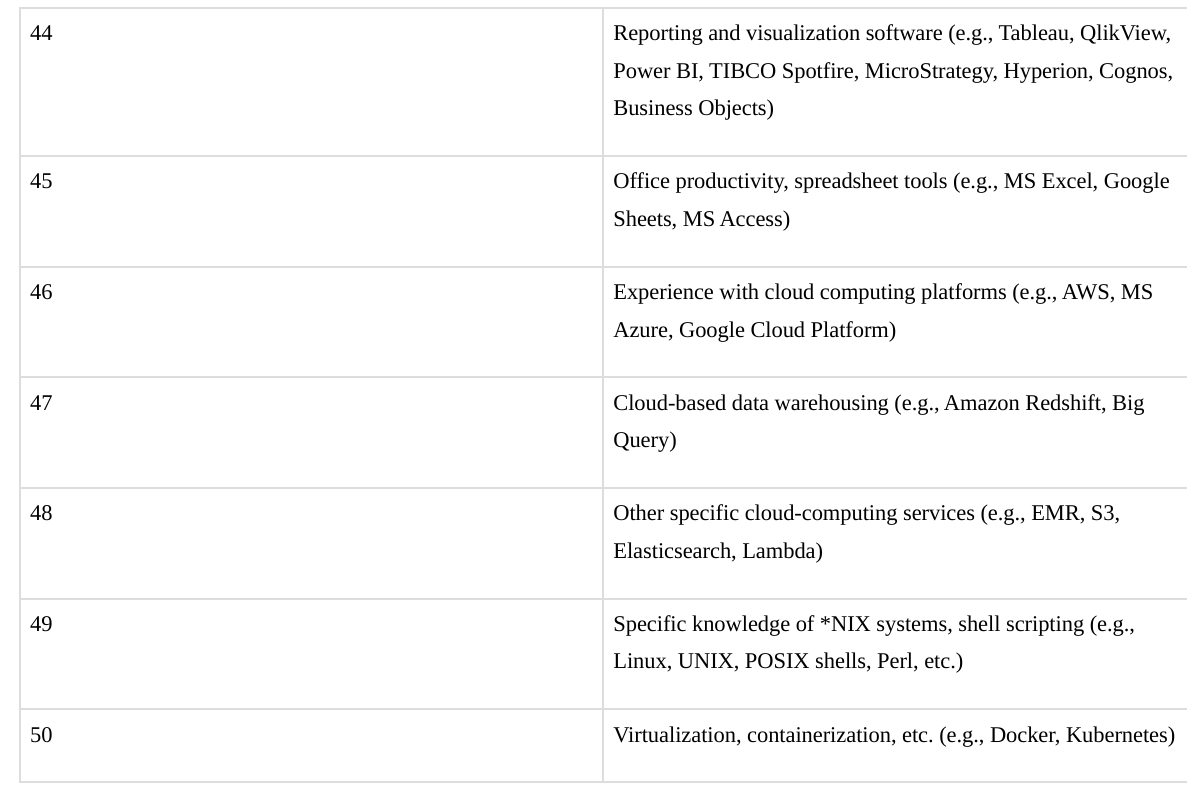
Table 3 in the main text includes a sample of key phrases extracted from LinkedIn professional profiles and job